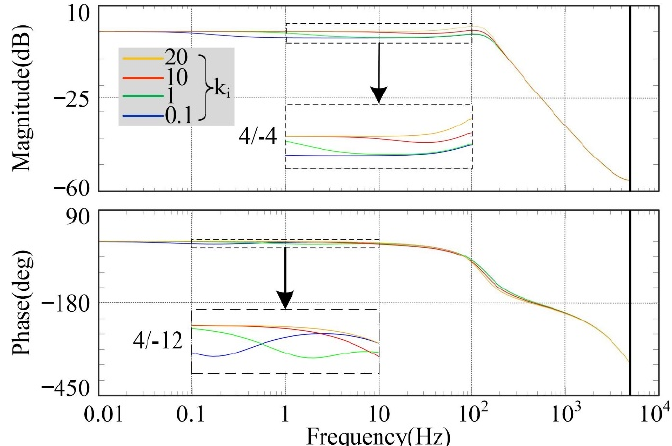
Figure 7. Bode diagrams of EP m ( z ) with different k i .